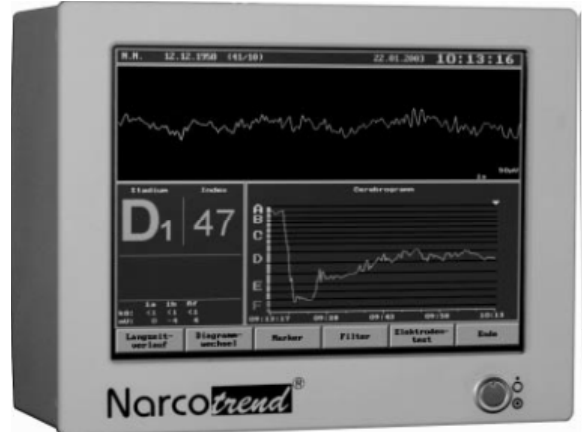
Figure 2. Frontal view of the Narcotrend Monitoring Device.